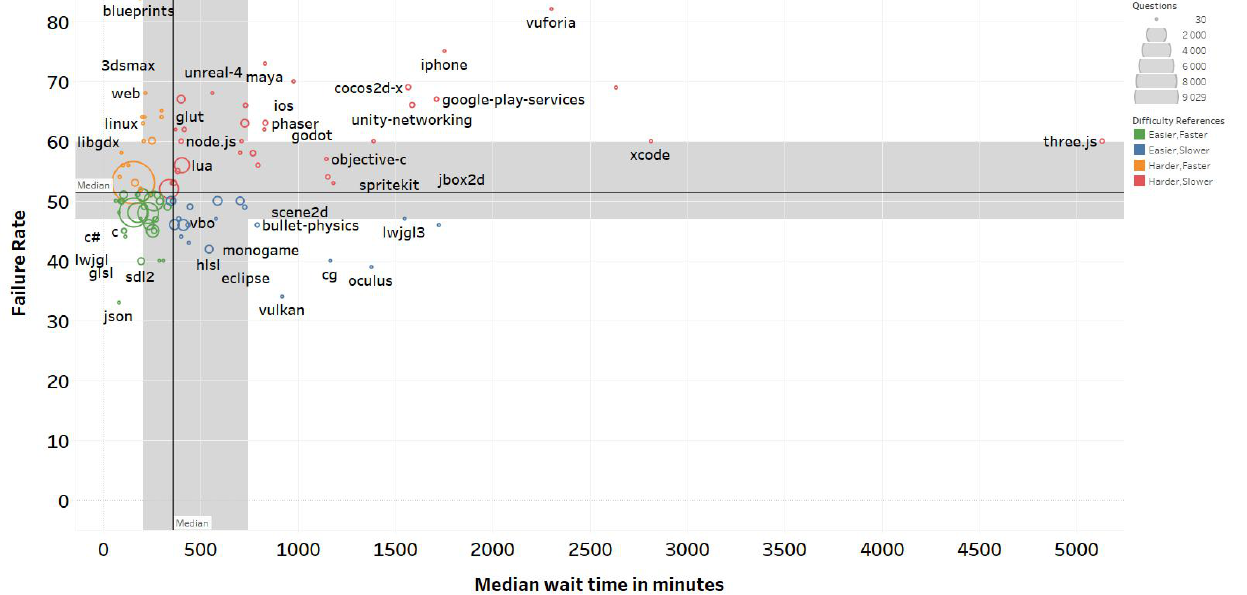
Figure 2. Community support for tech tags. Reference point is based on median values (51% for the Failure Rate, 351 min for the Wait Time). Circle sizes indicate the number of questions of the